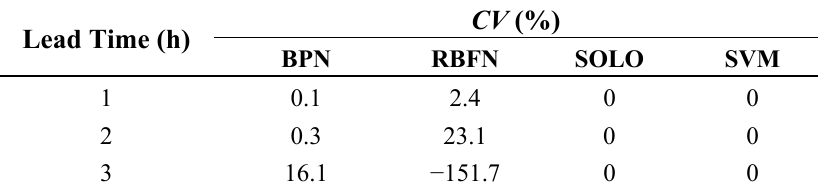
Table 3. CV values resulting from various NN-based